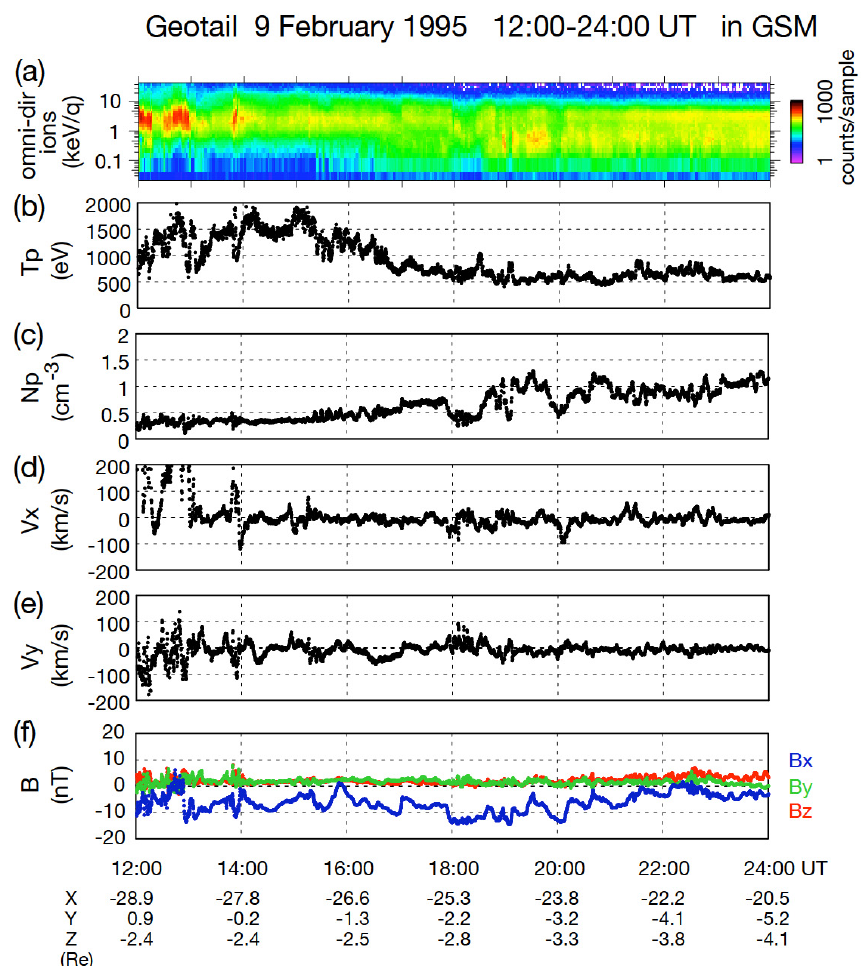
Fig. 8. Geotail observation between 12:00–24:00UT on 9 February 1995, in the same format as Fig. 1.